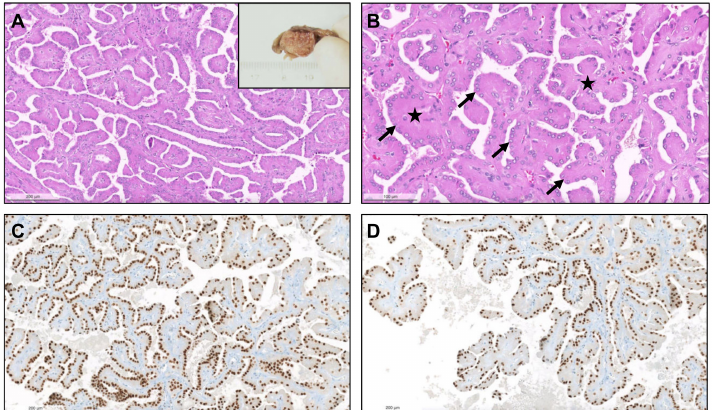
Figure 5. Papillary renal neoplasm with reversed polarity. The tumor was well demarcated, partly cystic and partly solid, yellowish and soft (inset). It was composed of small cells with oncocytic cytoplasm and small low-grade nuclei, displaced against the apical pole of the cells (( A , B ), arrows). The papillary cores were hyalinized (( B ), stars). The alignment of the nuclei “in a straight line” against the apical pole of the cells, lining the papillae contour, is further highlighted by GATA3, which is typically positive in these neoplasms ( C , D